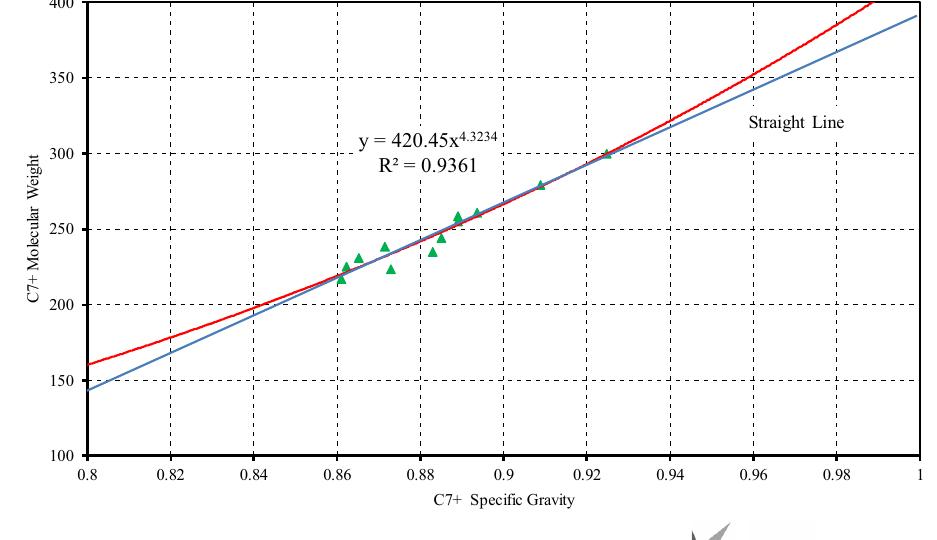
Fig. 2 Reported C7+ molecular weight and specific gravity of the reservoir